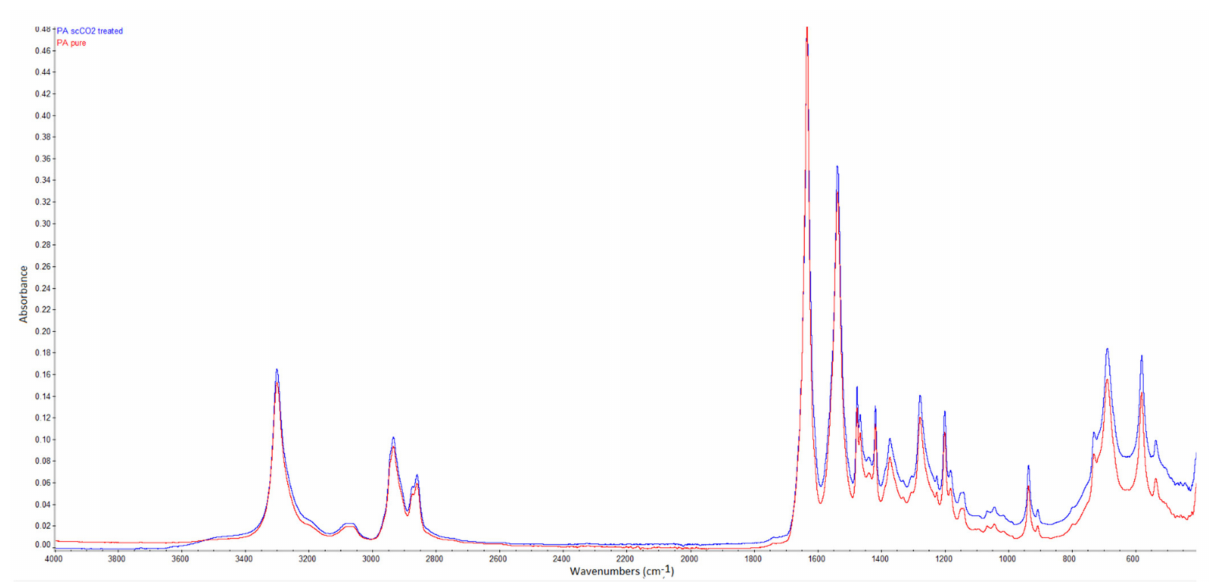
Figure A3. FTIR spectra of a neat and scCO 2 -treated membrane at 20 MPa and 40 ◦ C for 3 h.